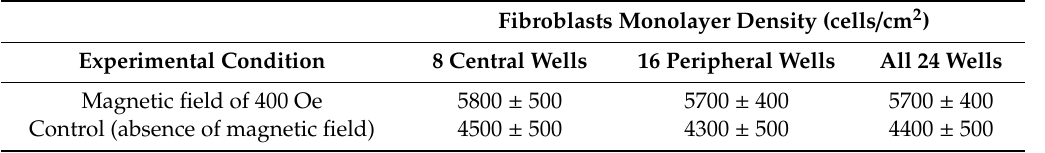
Table 2. Density of fibroblasts at di ff erent experimental conditions. No significant di ff erences were